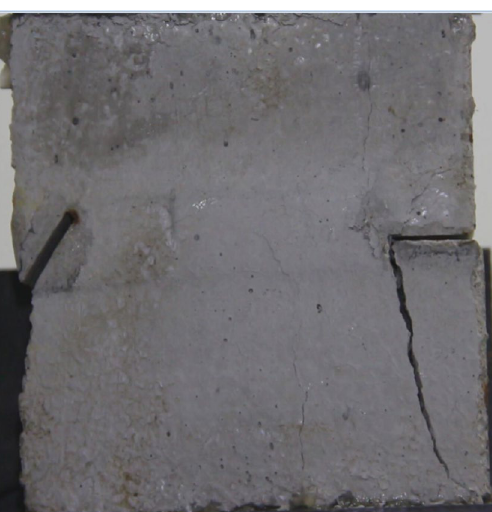
Figure 19. Photograph of a specimen showing tensile crack from the top surface caused by compression appearing and tensile wing crack